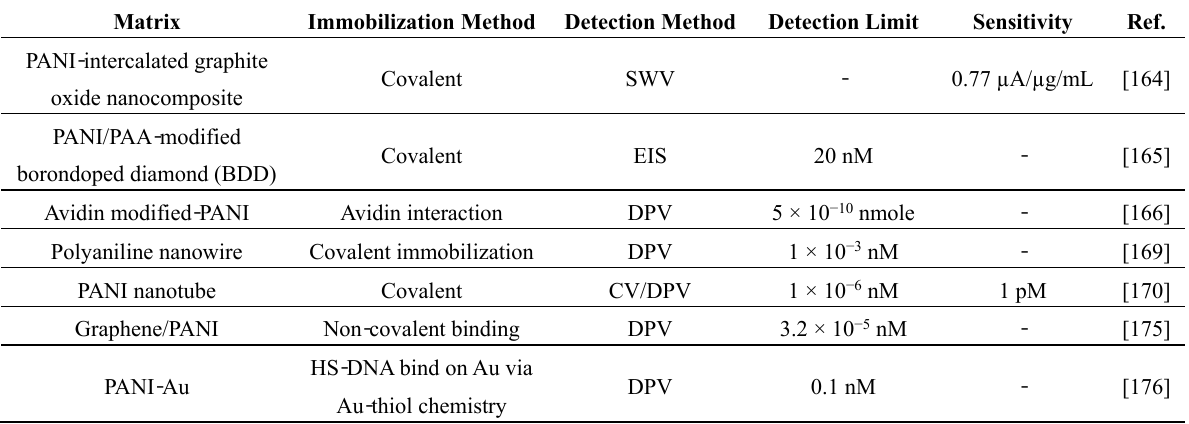
Table 3. Polyaniline (PANI)- and PANI-derivative-based DNA sensors and their performance in the detection of DNA